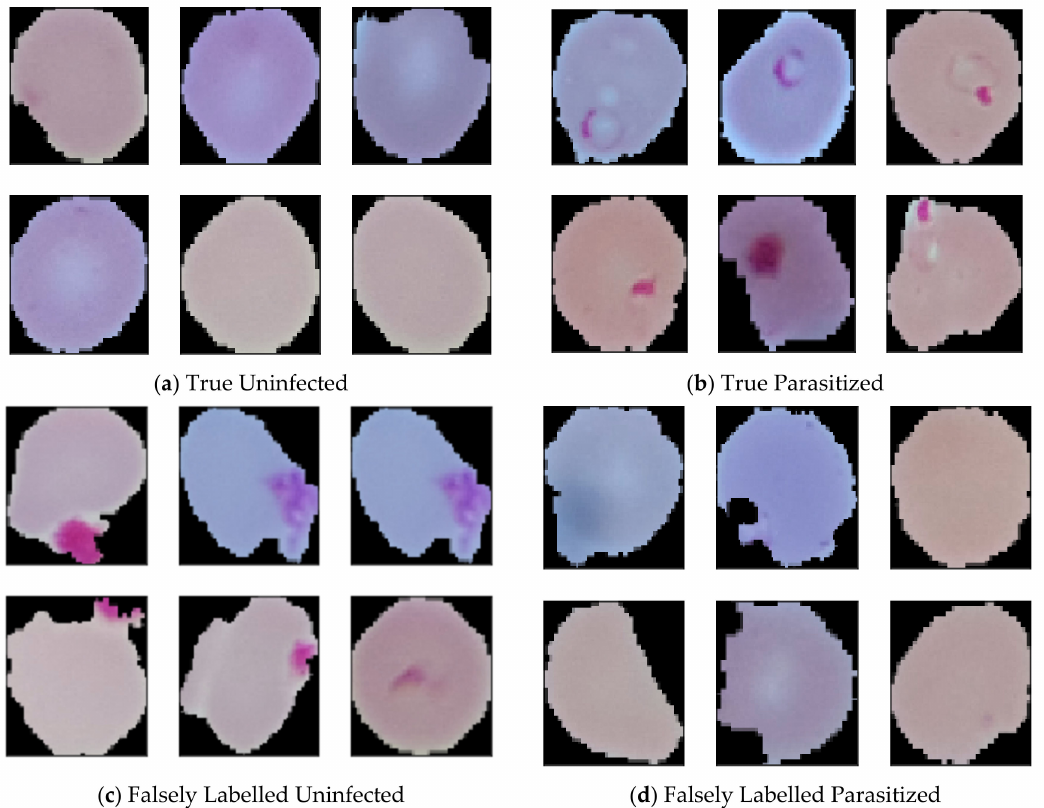
Figure 1. ( a ) Correctly labelled uninfected images ( b ) Correctly labelled parasitized images ( c ) Falsely labelled uninfected images and ( d ) Falsely labelled parasitized images.